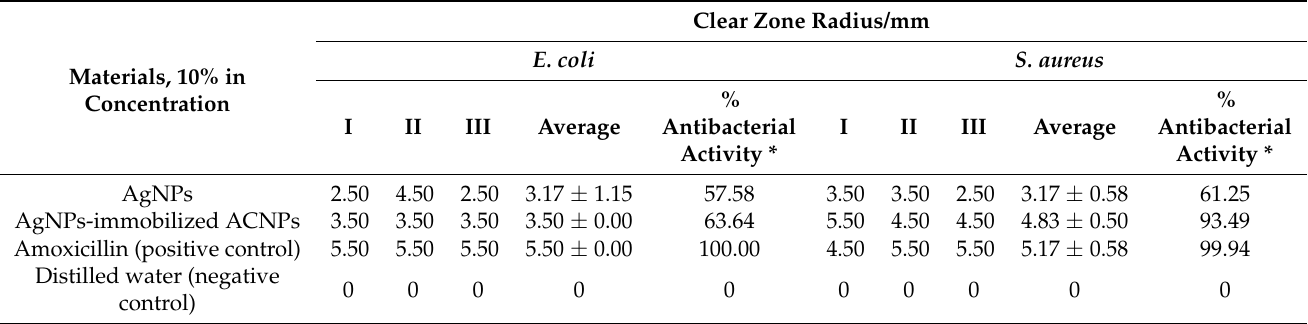
Table 1. Summary of the clear zone width generated around the paper disks wetted with the materials tested regarding their antibacterial